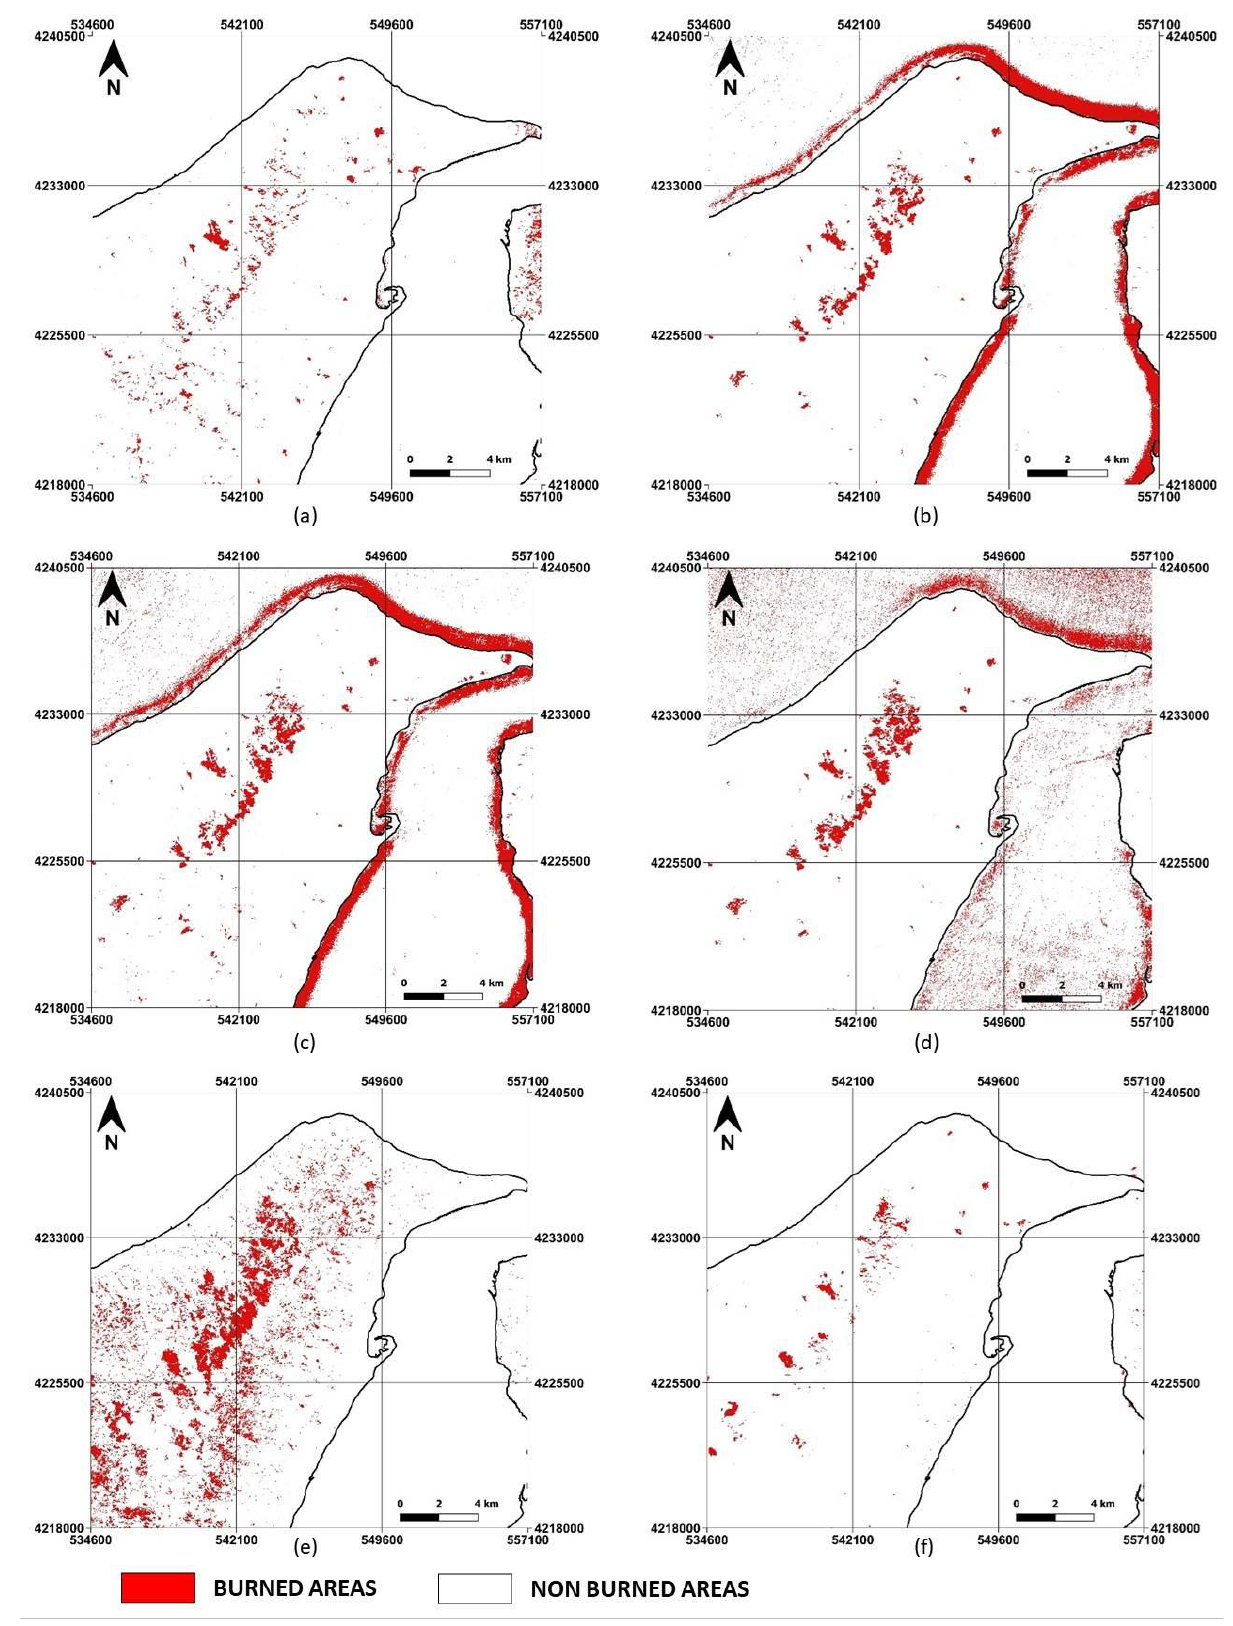
Figure 8. Maps of burned areas produced by the adopted indices using bi-temporal approach: